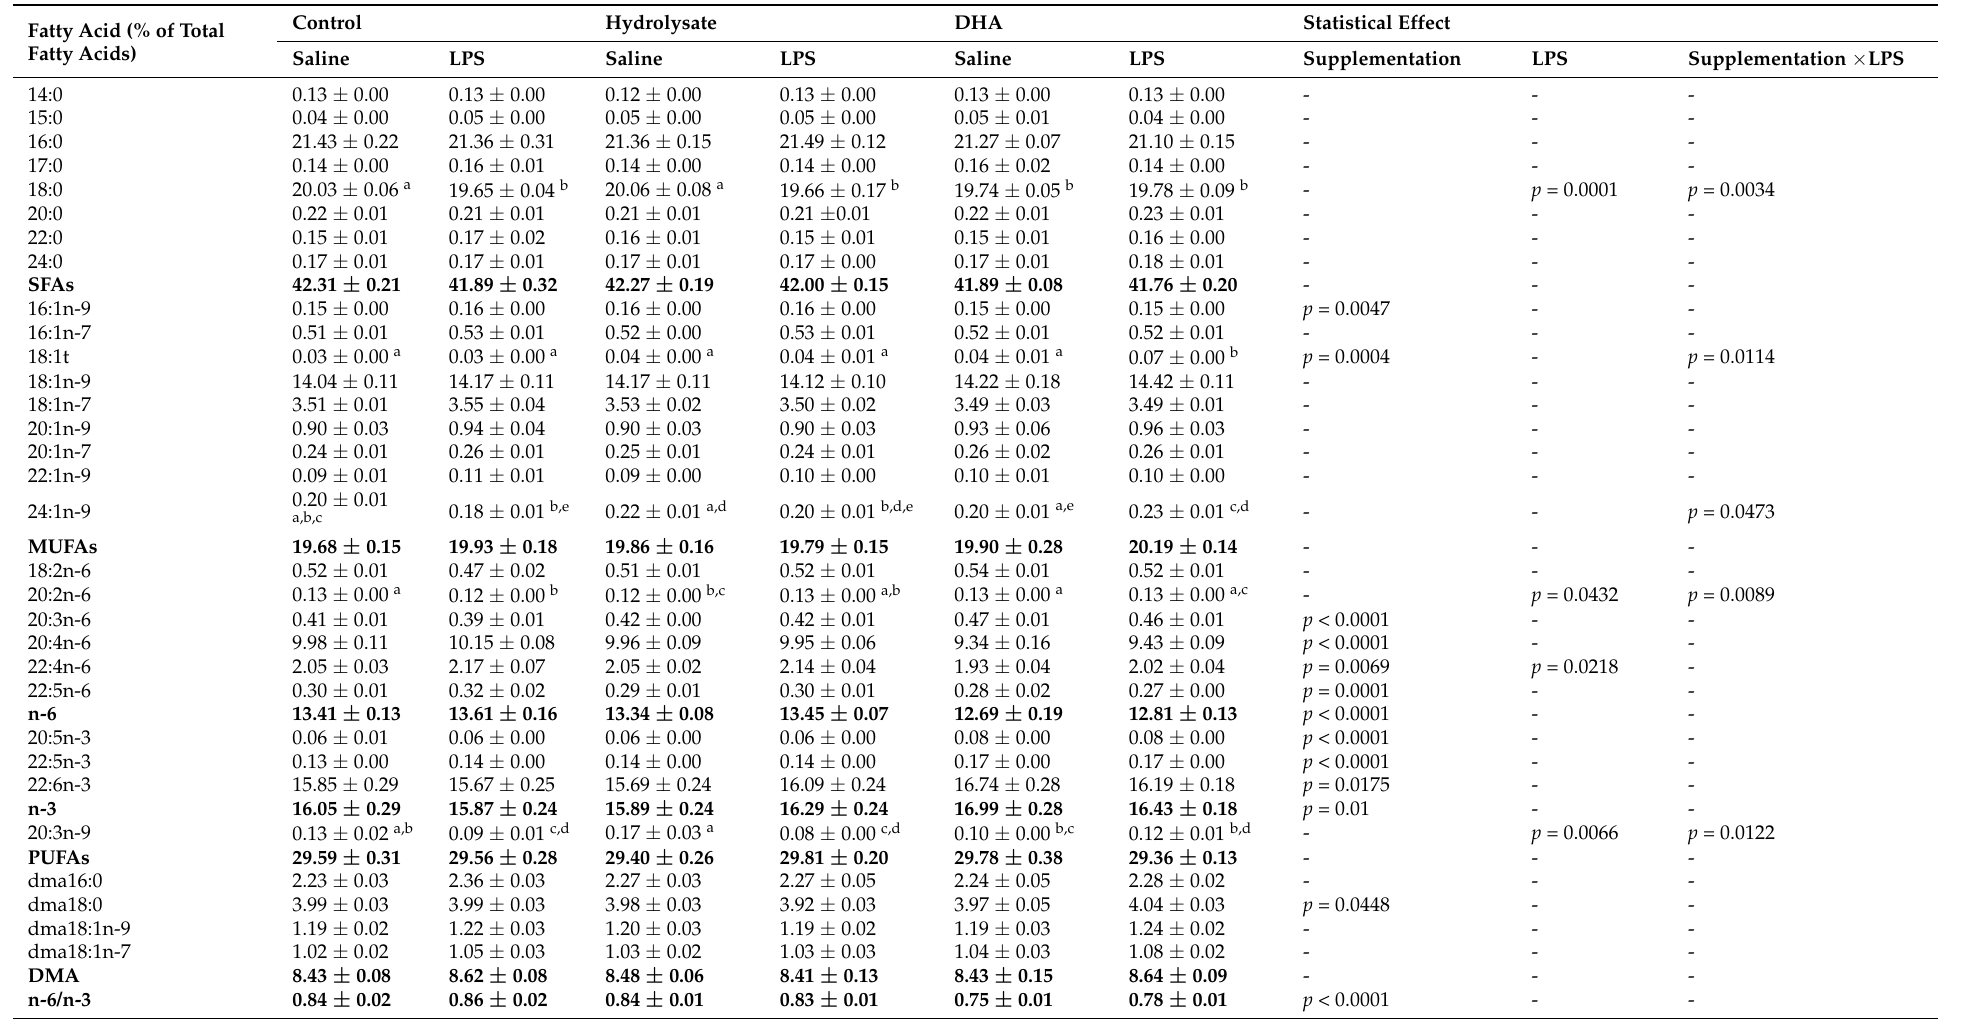
Table 2. Cortical fatty acid composition of mice fed orally with control solution, fish hydrolysate or DHA by daily gavage for 18 days, 2 h following LPS injection (125 µ g/kg). Control Hydrolysate DHA Statistical Effect Fatty Acid (% of Total Fatty Acids)